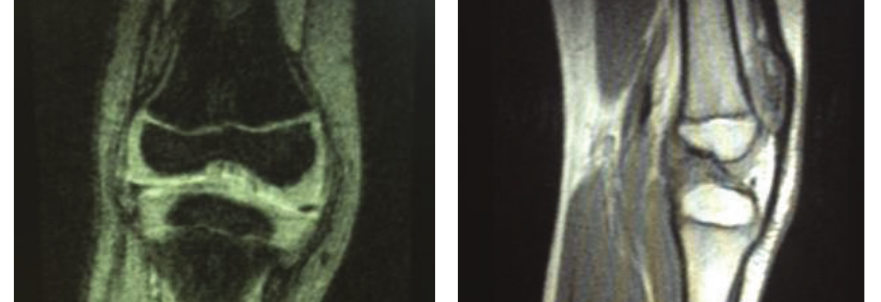
Figure 4: MRI of left knee.